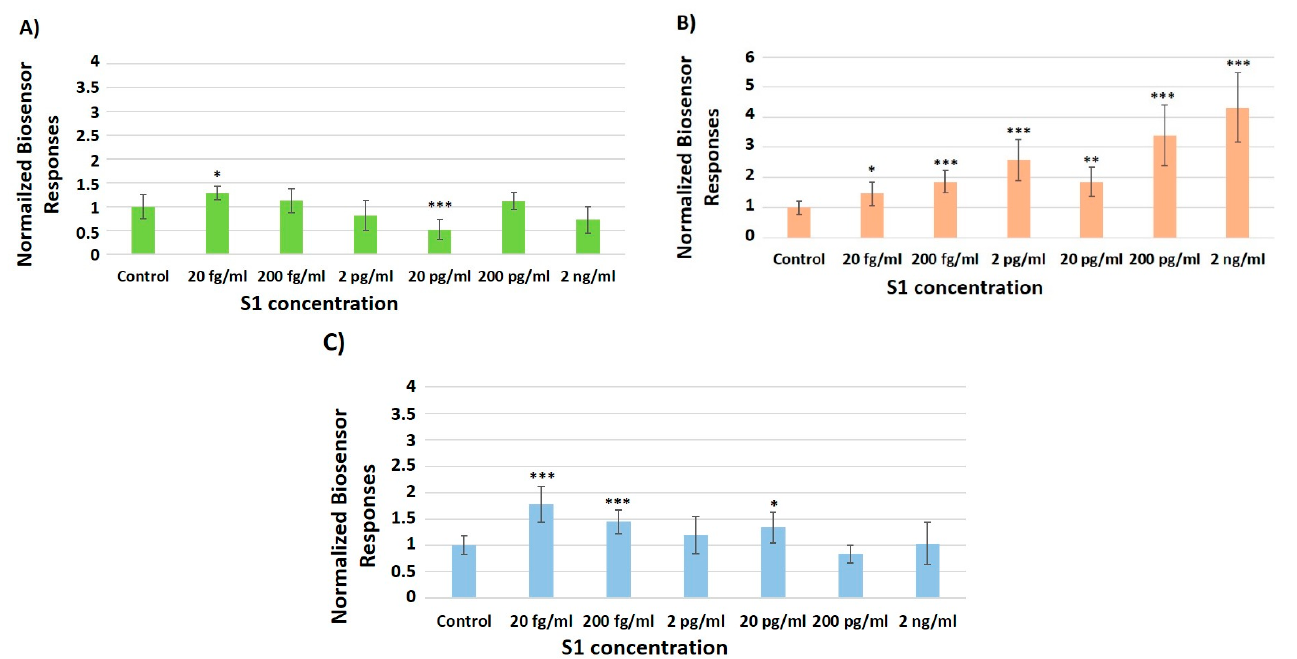
Figure 2. Distinct response of SK-N-SH/ACE2 membrane-engineered cells against the SARS-CoV-2 spike S1 pro- tein. Cells were membrane-engineered with different enzyme concentrations (( A ): 750 Units/mL, ( B ): 1500 Units/mL, ( C ): 2250 Units/mL). Control: response of membrane-engineered cells in plain PBS solution. ***: statistically significant different results ( p < 0.001); **: statistically significant different results ( p < 0.01); *: statistically significant different results ( p < 0.05); Results (mean ± SD) are expressed as ratio to control ( n = 16).